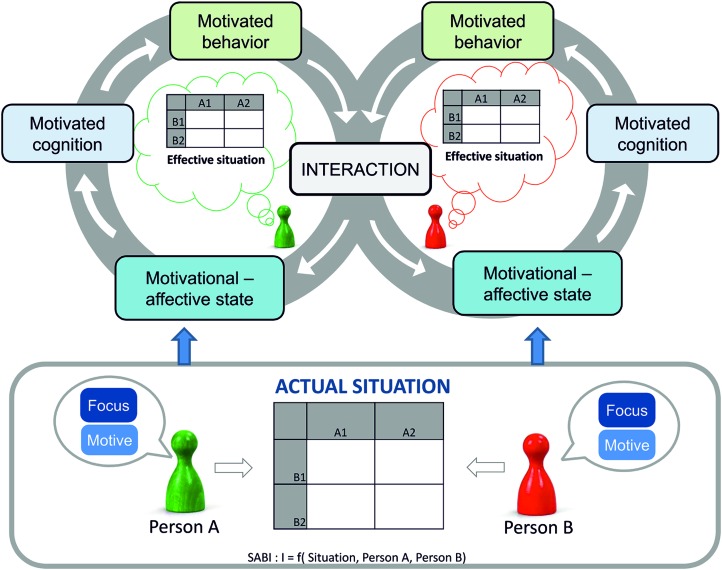
Loop2Loop model of social interactions (Jonas and Bierhoff, in press).